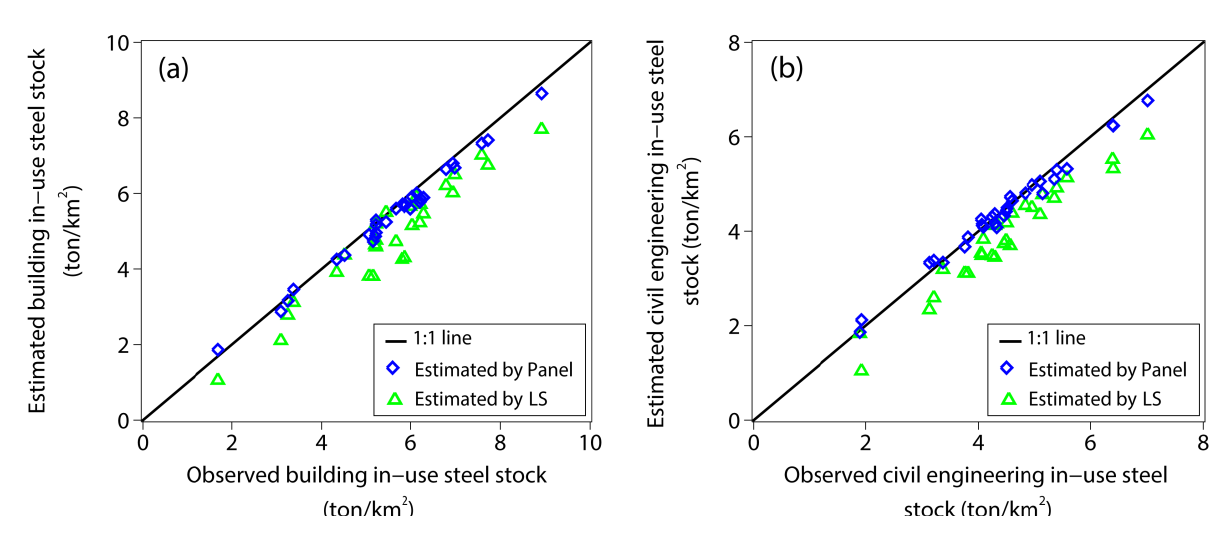
Figure 8. Comparisons between estimated IUSSB ( a ) and IUSSCE ( b ) by the panel regression models and LS models versus observed IUSSB and IUSSCE in